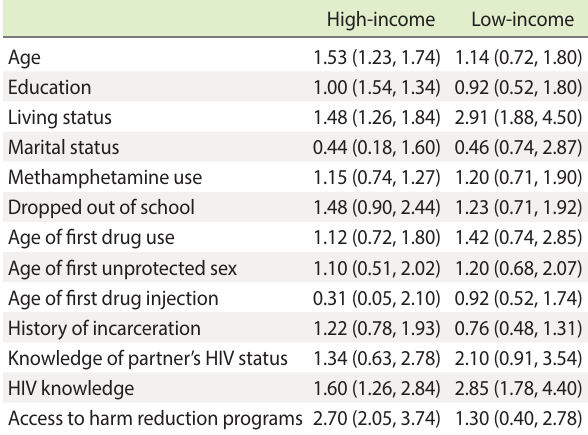
Table 2. Factors associated with unprotected sex in subgroups of PWID defined by economic status